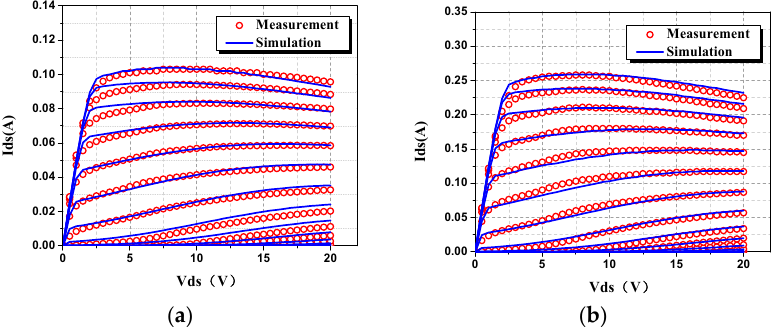
Figure 9. Comparison of simulated and measured DC characteristics of 0.1 µm AlGaN/GaN HEMTs: ( a ) 4 × 20 µm and ( b ) 4 × 50 µm.